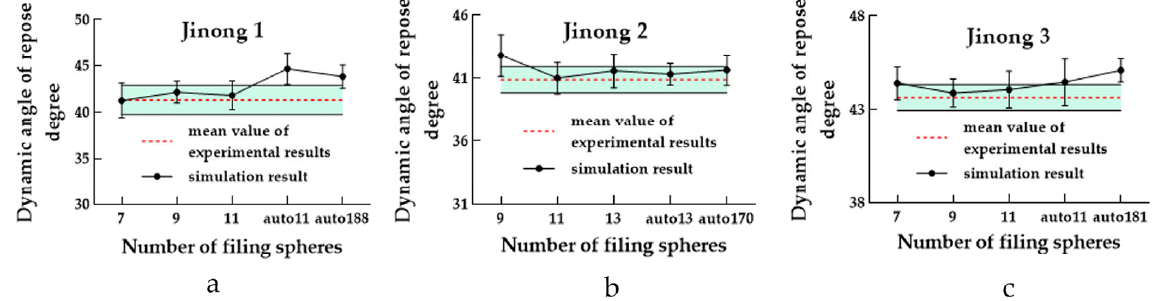
Figure 22. Simulation results of the rotating hub test. The experimental and simulated results of the dynamic angle of repose of particle models with different filing spheres are shown in Figure 22. Except for the 9-sphere model with Jinong 2, the mean of the simulated results of the MS models by manual filing converged to the mean value and fluctuated within the standard deviation of the experimental results. Except for the 11- and 188-sphere models with Jinong 1 and the 181-sphere model with Jinong 3 created by automatic filing, which was not closer to the mean of the experimental results, the other automatic filing models converged to the mean of the experimental results. Additionally, the CPU computation time was considered and increased with an increasing number of filing spheres, as shown in Figure 23.